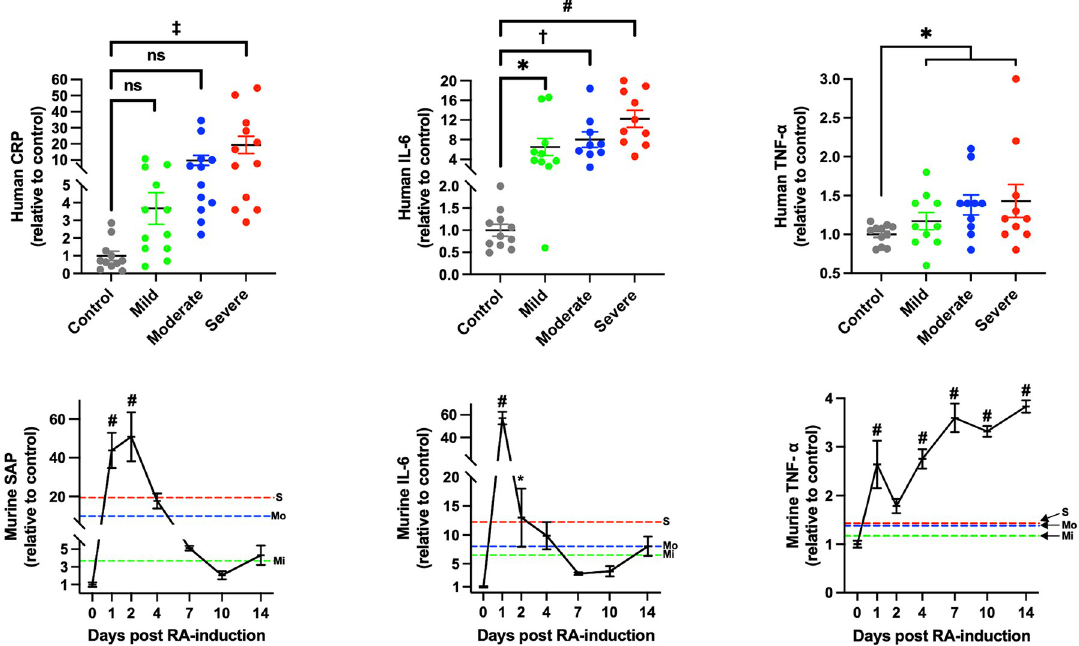
Fig 2. Analysis and comparison of systemic inflammation in the DTHA model and RA patients. Panel A-C : Serum levels of CRP (panel A), IL-6 (panel B) and TNF- α (panel C) from RA patients. Patients were chosen according to the DAS to represent three disease- states of severity (mild, moderate and severe). Each group consisted of 12 patients and age- and sex-matched healthy volunteers (control). CRP was analysed individually, and included 12 individuals in each group. One outlier was excluded in the healthy volunteer group. Due to space limiting reasons (limited wells in the 96-well) in the analysis of IL-6 and TNF- α , 10 patients were randomized for analysis in each disease group. Of these we excluded one outlier of IL-6 in the moderate group, one outlier of TNF- α in the control group. In addition, we excluded one IL-6 value in the control group, even though it did not meet our exclusion criterion, due to that the same individual had outlying both CRP and TNF- α values. Data is displayed as relative to control and presented as scatter plots with mean ± SEM. Statistical significance was calculated using one-way ANOVA with Bonferroni’s multiple comparisons test for CRP and IL-6, and unpaired two-tailed t -test of control vs intervention (mild, moderate and severe combined) for TNF- α . Panel D-F : Temporal profiles of serum levels of murine SAP (panel D), IL-6 (panel E) and TNF- α (panel F) in DTHA mice relative to control. n = 10 for control group, n = 5 for other time points. Of these, two outliers for both SAP and IL-6 (representing the same two mice) were excluded in the control groups. Even though it did not meet our exclusion criterion, we chose to also exclude the corresponding TNF- α values from these two mice. Red grid line in graphs represents corresponding mean relative human value in severe human RA patients, blue grid line in graphs represents corresponding mean relative human value in moderate human RA patients, green grid line in graphs represents corresponding mean relative human value in mild human RA patients. Data is shown as mean ± SEM. S = severe, Mo = moderate, Mi = mild. Statistical significance was calculated in mice, relative to control, using one-way ANOVA with Bonferroni’s multiple comparisons test. ns = non-significant, � P < 0.05, † P < 0.01; ‡ P < 0.001, # P < 0.0001. DTHA, delayed type hypersensitivity arthritis; CRP, C-reactive protein; IL-6, interleukin 6; TNF- α , tumor necrosis factor α ; DAS, Disease Activity Score; SAP, serum amyloid P